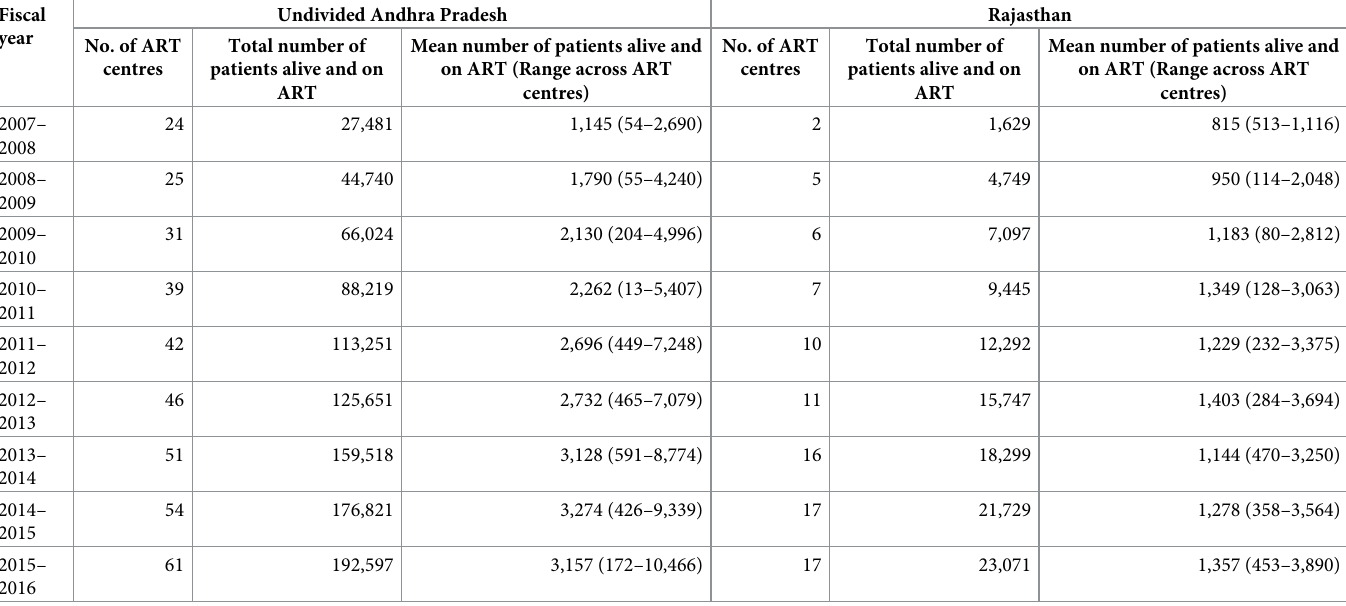
Table 1. Patients alive and on ART in public sector ART centres in undivided Andhra Pradesh and Rajasthan states in India from the fiscal year 2007–2008 to 2015–2016.